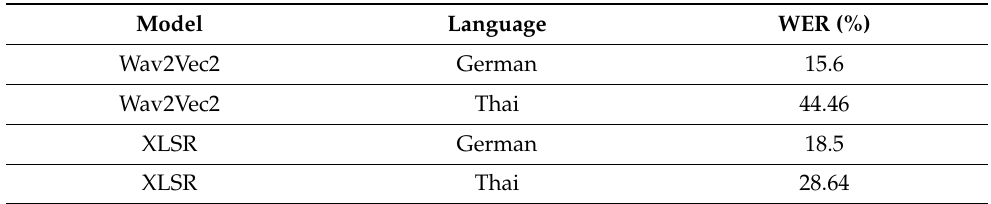
Table 2. Word error rate (WER) of our proposed front-end network fine-tuned by the speech recogni- tion domain on the Common Voice 7.0 dataset.